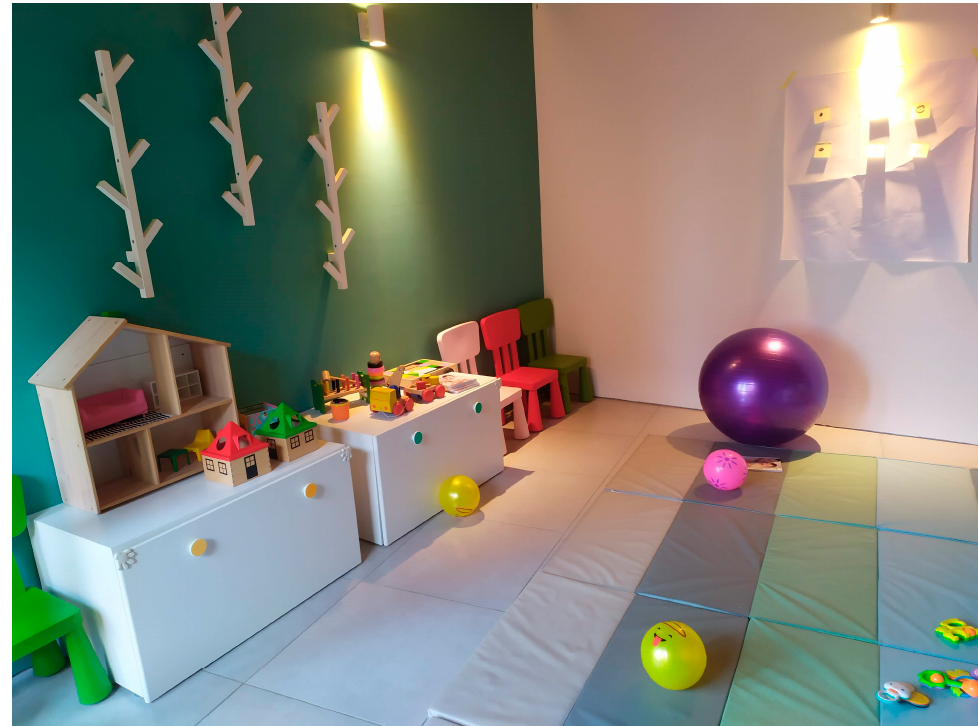
Figure 5. A detail of the interior of the socio-educational center (2023)